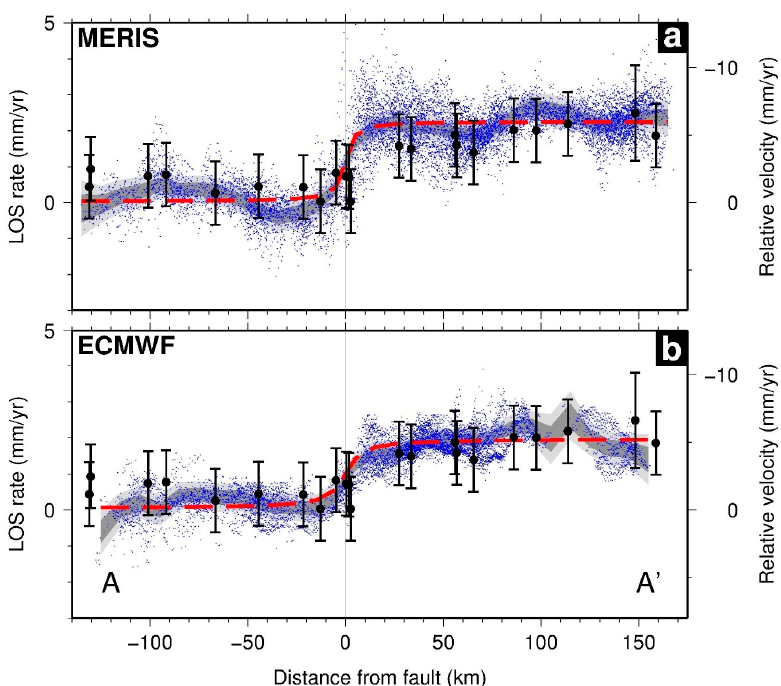
Figure 4. ( a ) Average rate profile produced by projecting all points of the MERIS-corrected rate-map onto the line A-A’ indicated in Figure 2. The thick grey bands show the 1- and 2- σ error bounds on LOS rate. Blue points are individual pixels from the rate-map. Black bars are the horizontal GPS velocities and error bounds shown in the footprint of track 18 in Figure 2, and converted into satellite LOS rates. Velocities predicted by our best-fit slip model are plotted as a red dashed line. ( b ) Same as for (a) but for ECMWF-corrected rate-map indicated in Figure 2b.